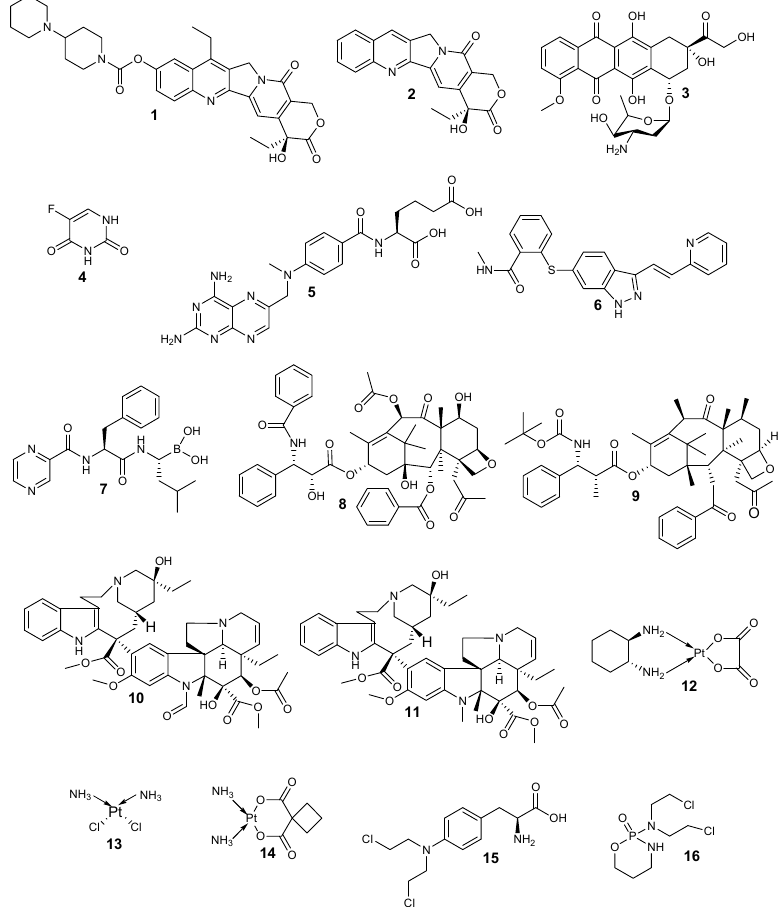
Figure 1. Anticancer drugs based on their mode of action.